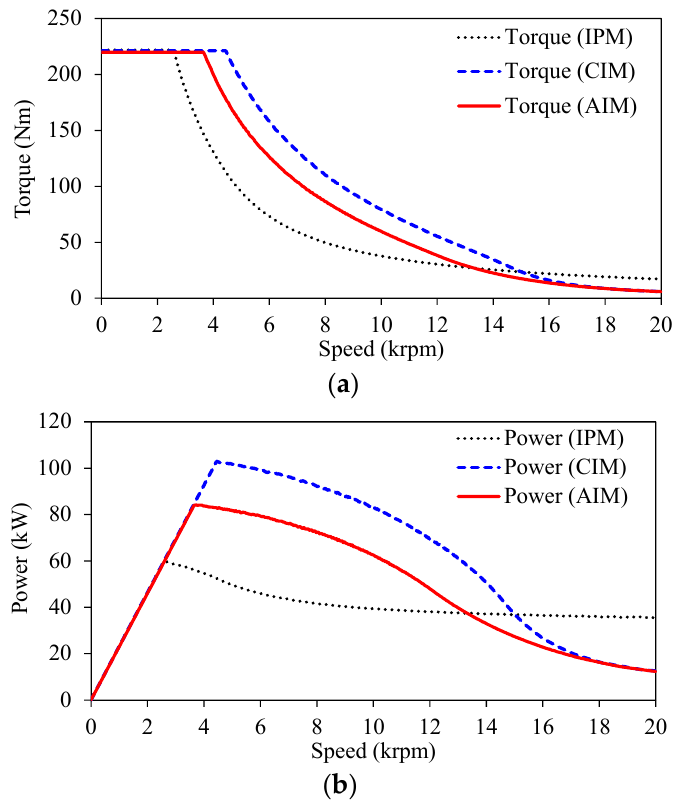
Figure 6. Flux-weakening characteristics. ( a ) Torque-speed characteristics. ( b ) Power-speed characteristics.